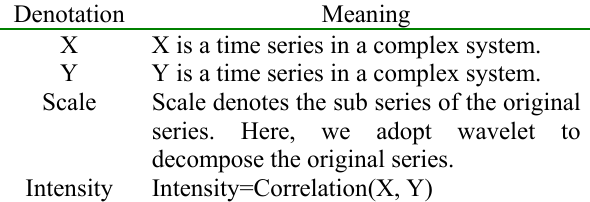
Table 2. Denotation of time series’ intervention rule